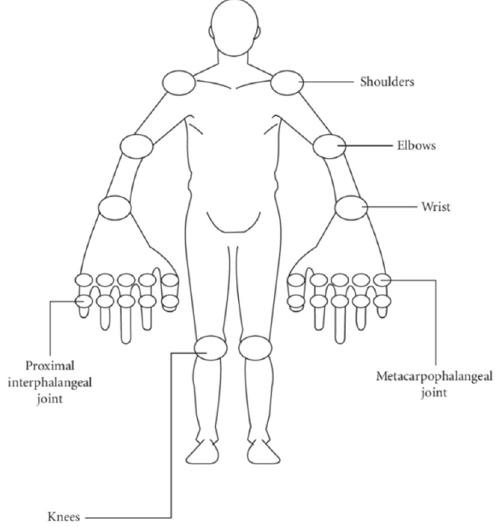
Figure 7. Self-administered index (SAI) modified from [34].